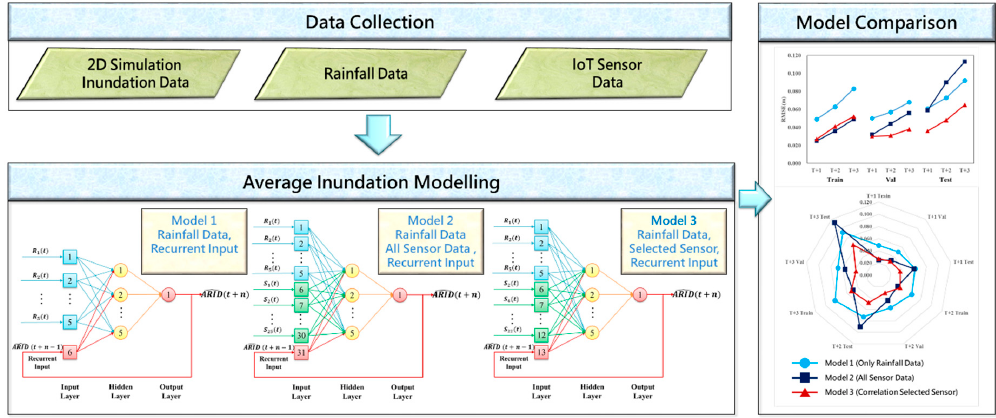
Figure 4. Research framework. 186